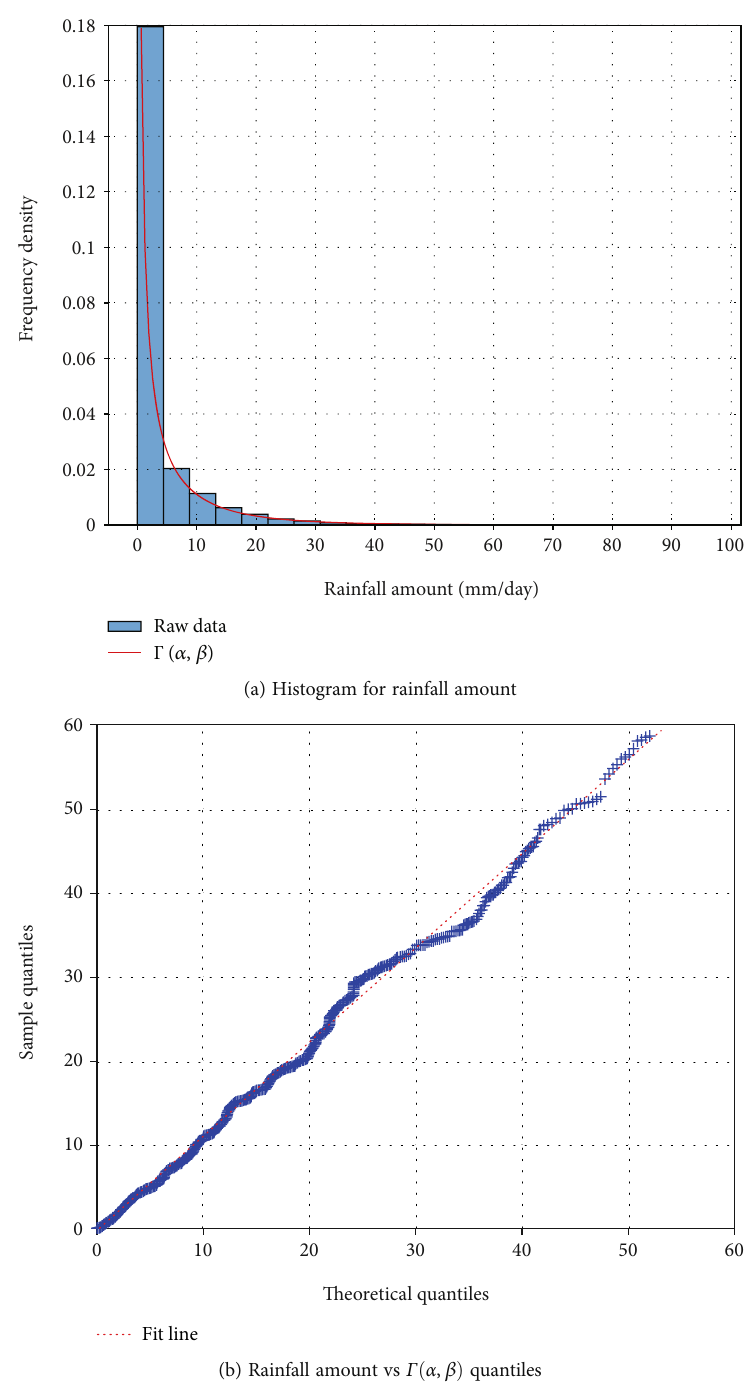
Figure 1: Probability density of daily rainfall amount for